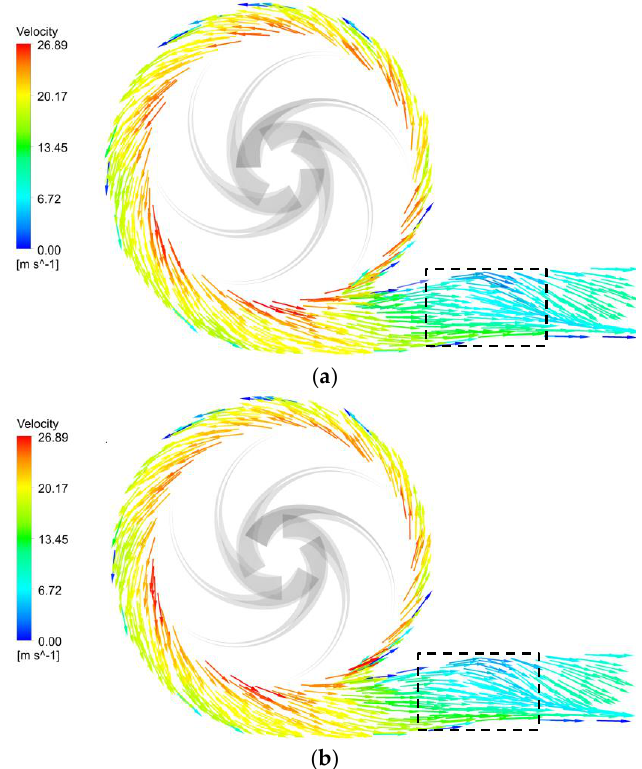
Figure 26. Velocity vector distribution on the middle section of the discharge chamber plane under Q des : ( a ) Impeller phase at 0°; ( b ) Impeller phase at